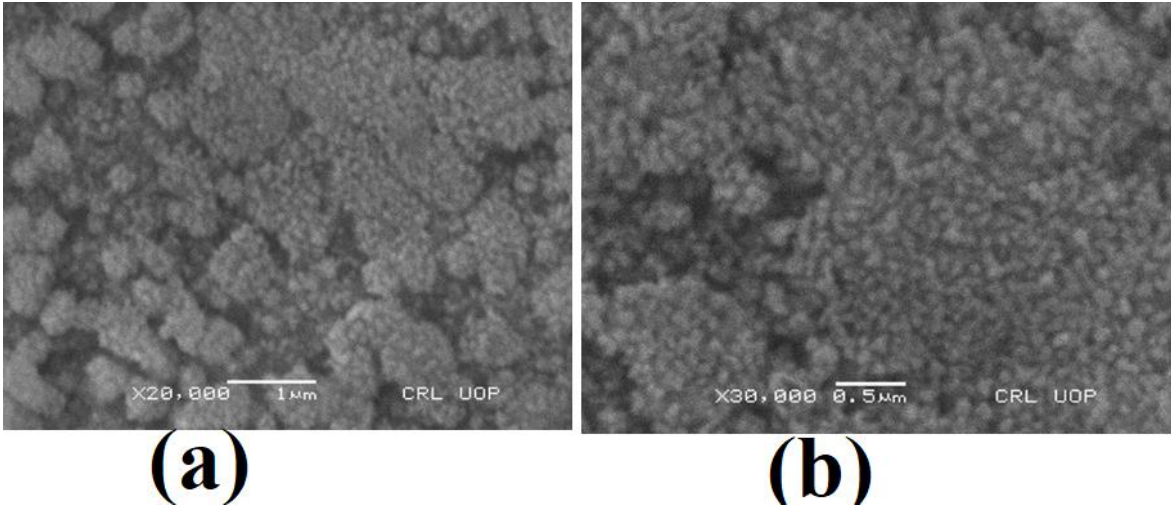
Figure 5. SEM micrographs of the AgNP nanopowders at ( a ) 1 micrometer and ( b ) 0.5